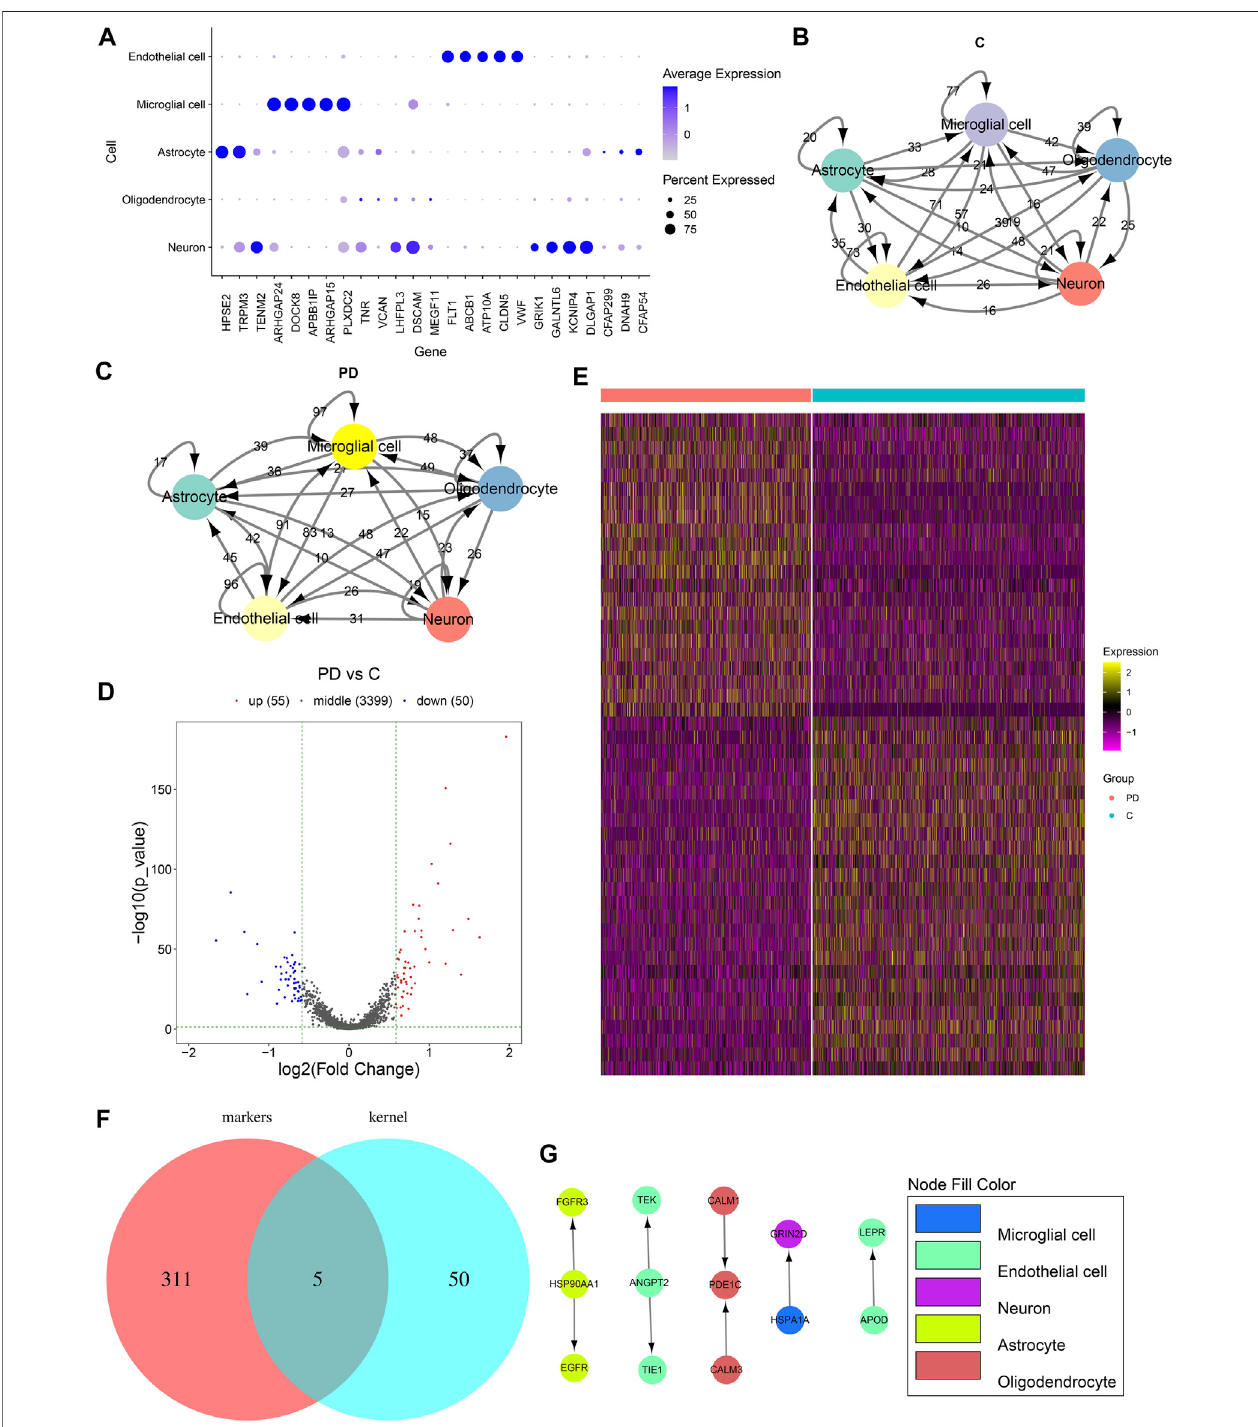
FIGURE 4 | Cell – cell communications across cell clusters. (A) Scatter diagram for the top fi ve marker genes of each cell cluster. The size of the dot indicates the percentageofthegene expression inacell. Thecolorofthedot indicates theexpression levelofthegenein thecell. Blueindicates high expression. (B) Ligand – receptor relationship networks of healthy samples. The arrow points to the recipient cell. The width of the line is proportional to the number of ligand – receptor gene relationships. (C) Ligand – receptor relationship networks of PD samples. The arrow points to the recipient cell. The width of the line is proportional to the number of ligand – receptor gene relationships. (D) Volcano plot and (E) Heat map for the DEGs between PD and healthy endothelial cells. (F) Venn diagram for the common genes between upregulated genes and all other marker genes in the cell – cell communication network. (G) Relationships between upregulated marker genes. The arrow direction points from the ligand to the